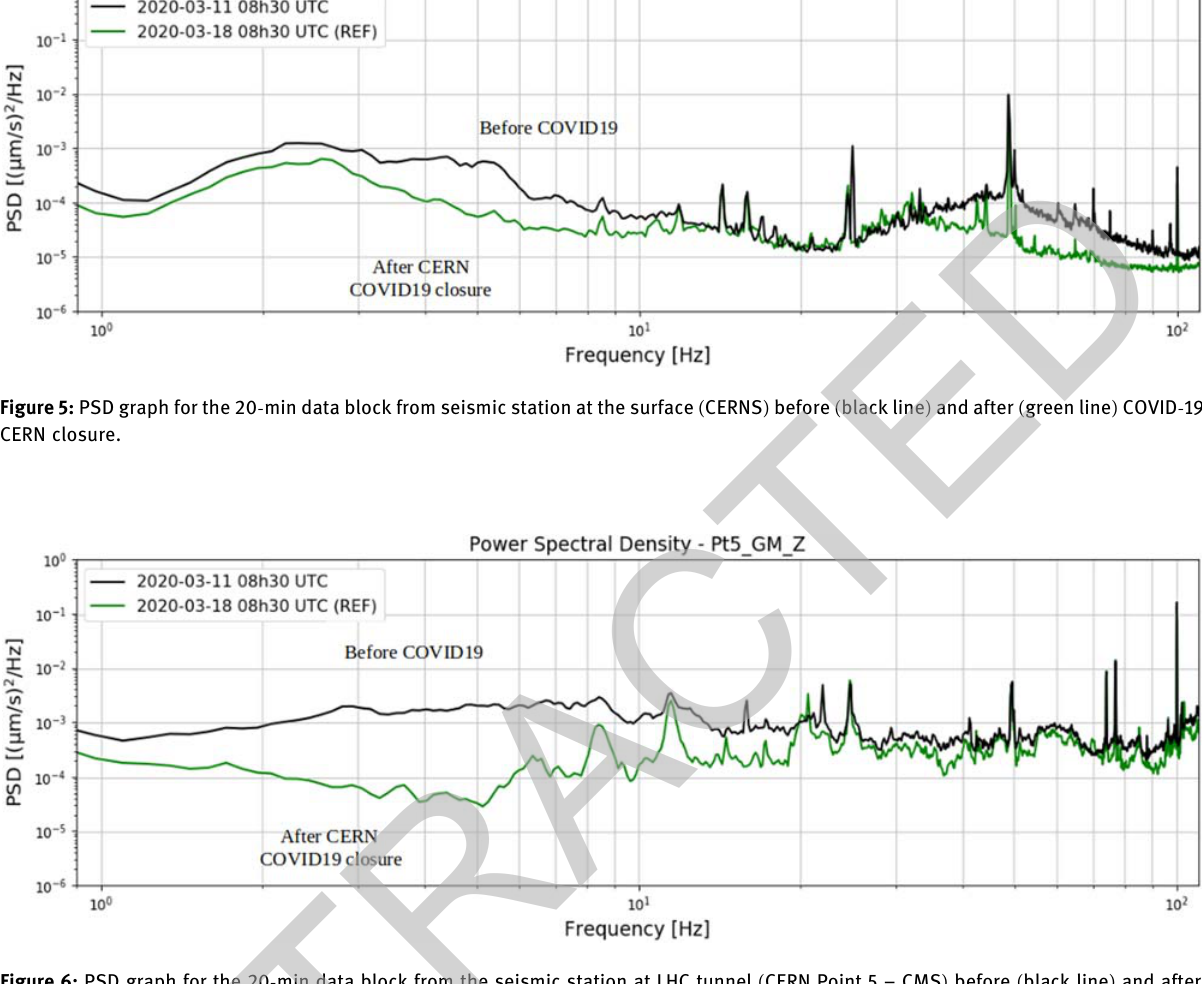
Figure 6: PSD graph for the 20 - min data block from the seismic station at LHC tunnel ( CERN Point 5 – CMS ) before ( black line ) and after ( green line ) COVID - 19 CERN closure.